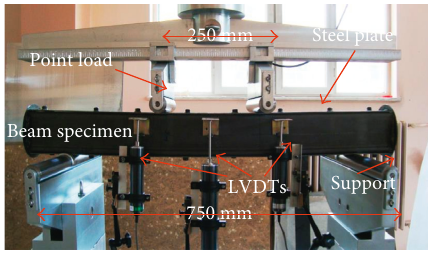
Figure 7: Beam test